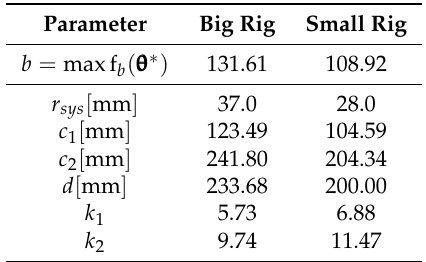
Table 1. Optimal System Design Parameters.